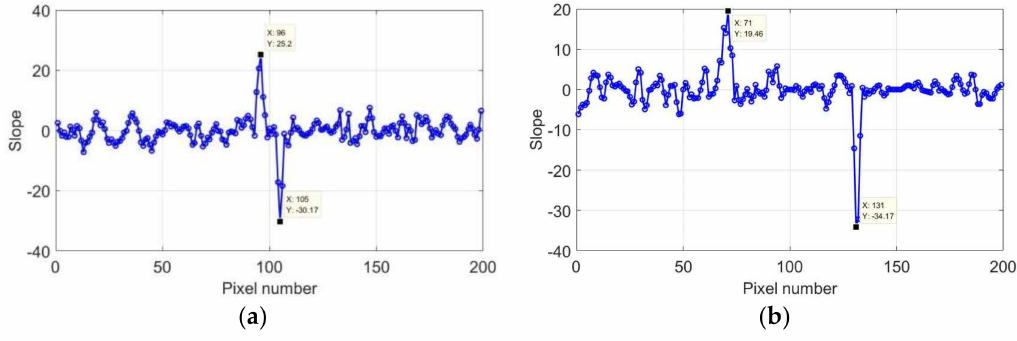
Figure 13. Slope of first derivative of 1.5 mm: ( a ) horizontal and ( b ) vertical direction.